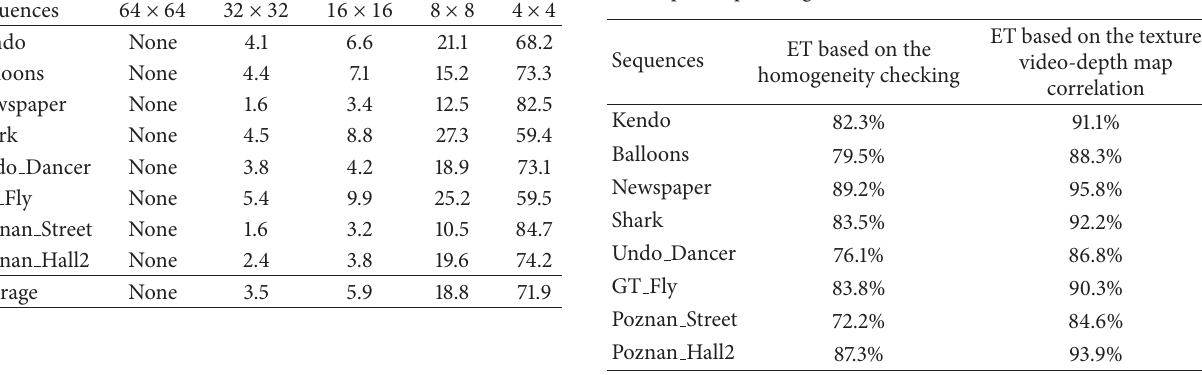
Table 2: Statistical analysis different PU size distributions in DMM. Table 3: Statistical analysis for accuracies of ET methods in intradepth map